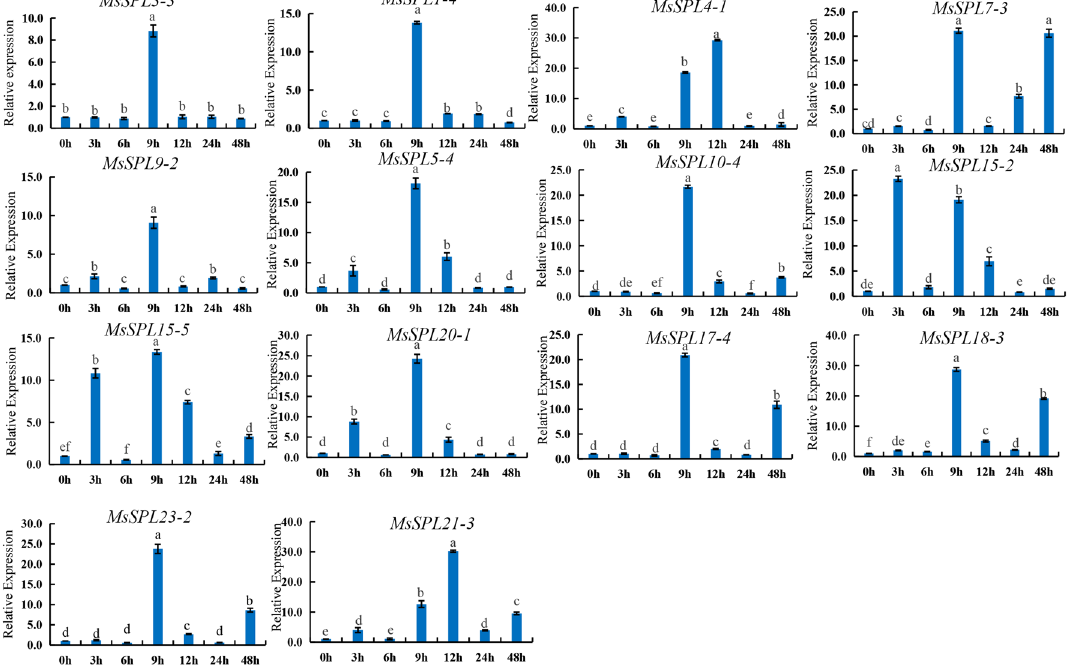
Figure 7. Gene expression of 14 MsSPL genes under NaCl treatment at 0 h, 3 h, 6 h, 9 h, 12 h, 24 h and 48 h was analyzed using qRT-PCR. Error bars represent standard errors of three biological replicates. The differernt lowercase letters indicate significant differences at the P < 0.05